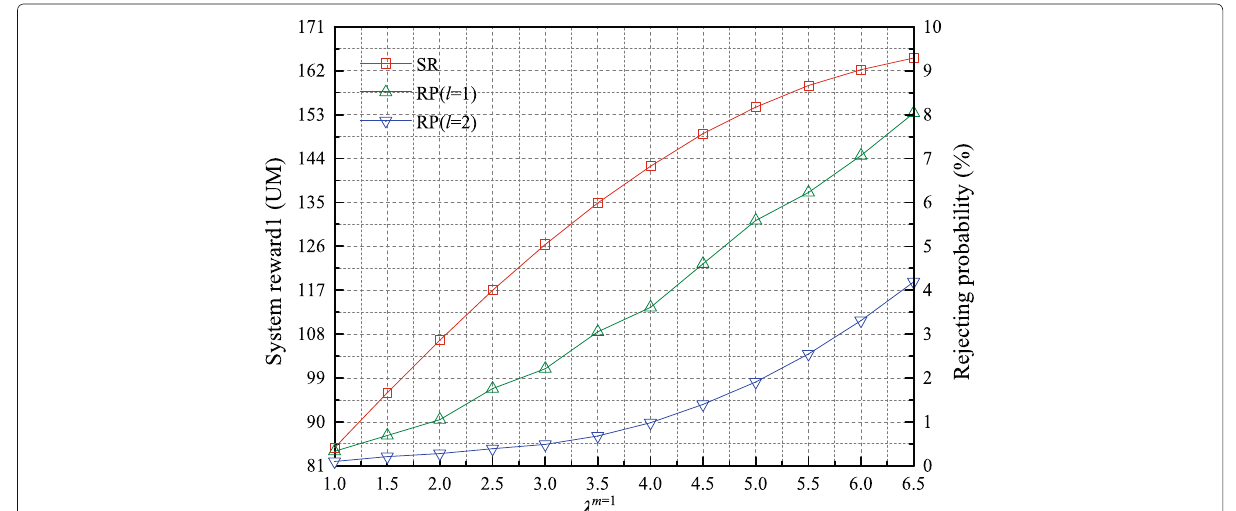
RP( l = 1) first decreases and then increases. When λ l = 1 is small, with the increasing λ l = 1 , RP( l = 1) decreases, and more 1-level task requests are accepted to increase the SR. At the same time, a small λ l = 1 allows fewer 2-level task requests are rejected, making RP( l = 2) increase slowly.